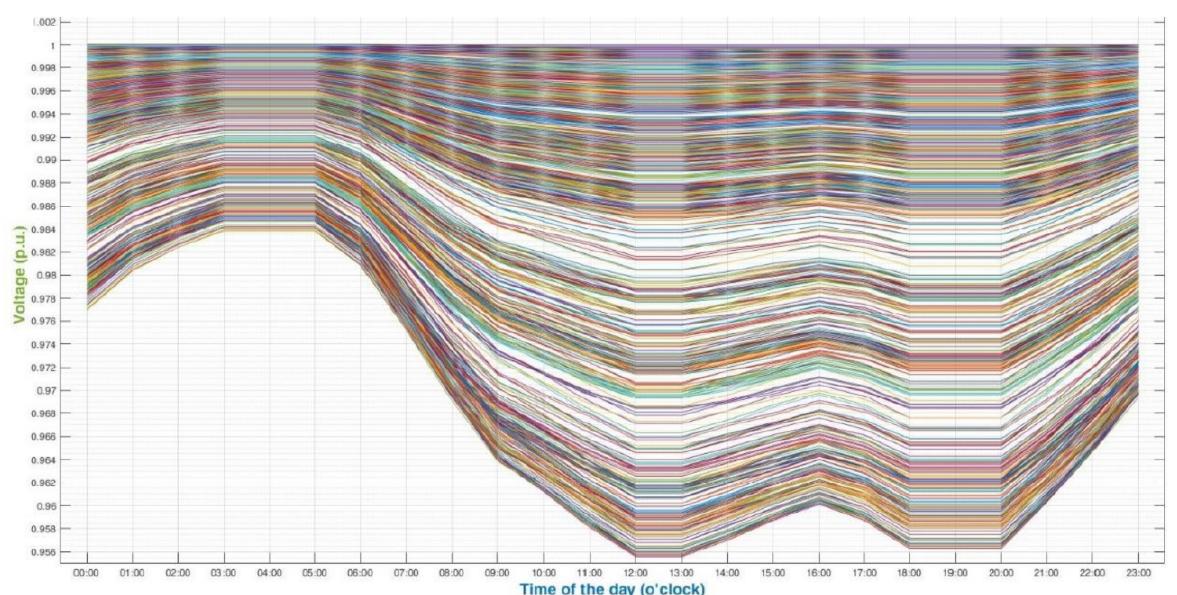
Figure 13. Voltage magnitude per unit of the buses for the LV and MV levels when CS2 (case 2) is